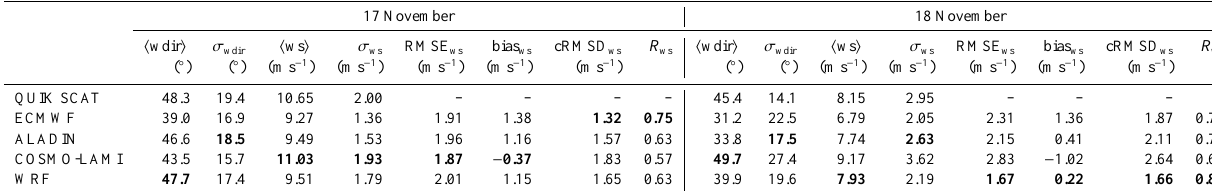
Table 2. Statistical parameters of the five wind datasets for the two passes, on 17 November (left) and 18 November (right) 2008. The statistical parameters are the mean wind direction and speed with their standard deviations ( σ ), and root mean square error (RMSE), bias, centred root mean square di ff erence (cRMSD) and correlation coe ffi cient ( R ) of the model wind speed with respect to the scatterometer observations. In bold the best